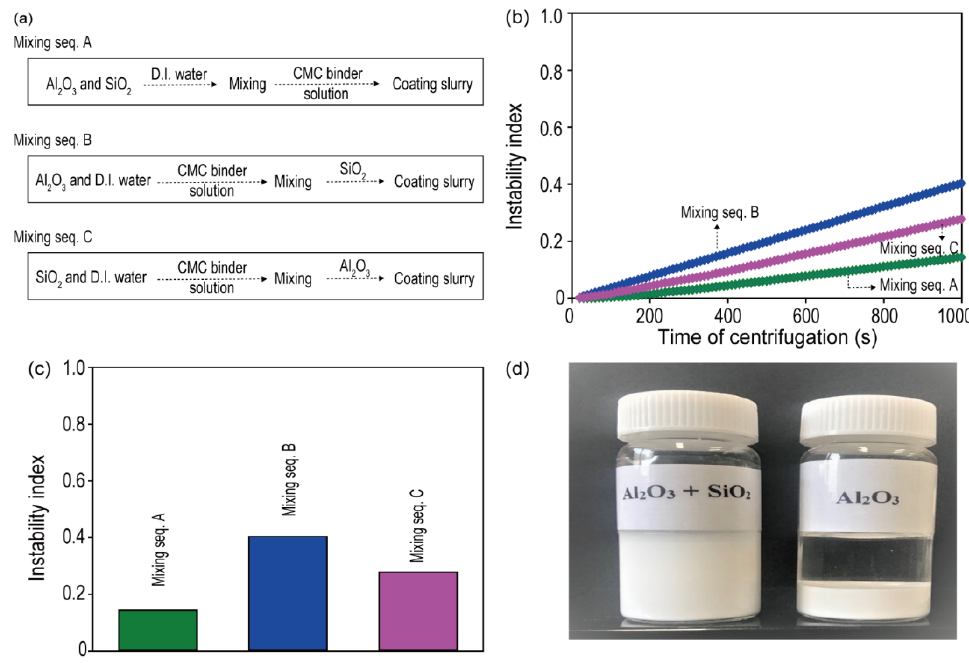
Figure 2. ( a ) Mixing sequences for the preparation of aqueous dual ceramic coating slurries contain- ing SiO 2 and Al 2 O 3 . ( b ) Instability indices of aqueous dual ceramic coating slurries containing SiO 2 and Al 2 O 3 , prepared according to the different mixing sequences shown in Figure 2a and deter- mined using Lumisizer ( a ) as a function of centrifugation time and ( c ) at a 1000 sec centrifugation time. ( d ) Digital camera images of the aqueous dual ceramic coating slurries containing SiO 2 and Al 2 O 3 , prepared according to mixing sequence A and Case 4 shown in Figure 1 after 30 d of storage under gravity at 25 °C.